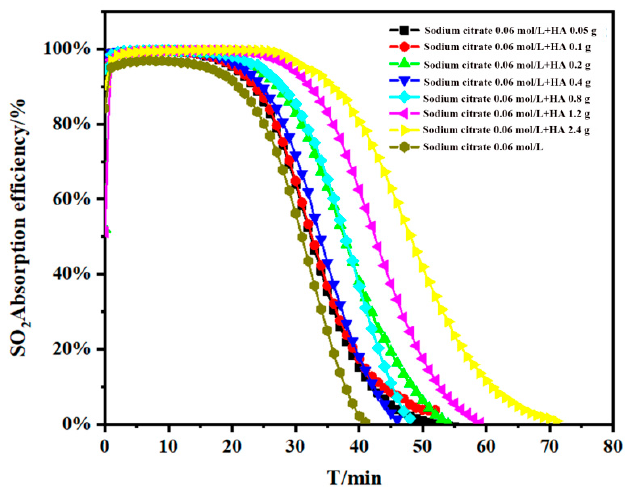
Figure 4. Effect of HA–Na additive on the desulfurization effect. SO 2 = 2300 ppm, gas flow = 1.68 L/min, absorption solution = 60 mL and Ci-Na = 0.06 mol/L and 25 ° C.